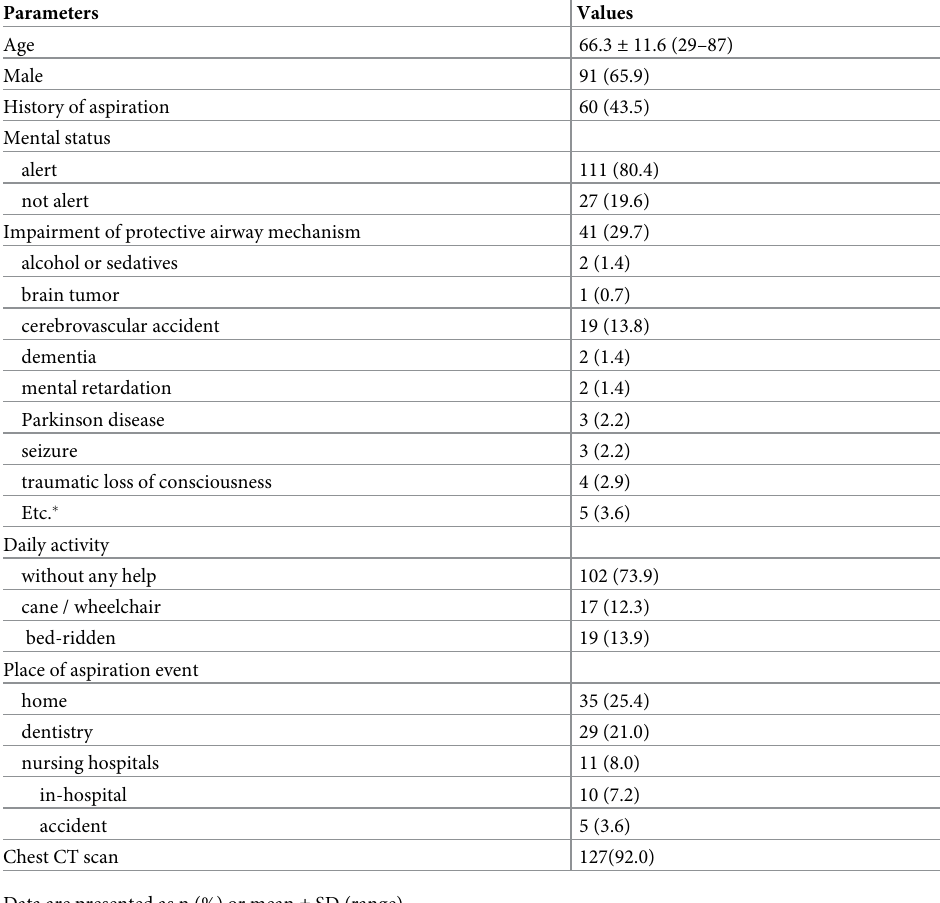
Table 1. Demographic characteristics of the patients (N =